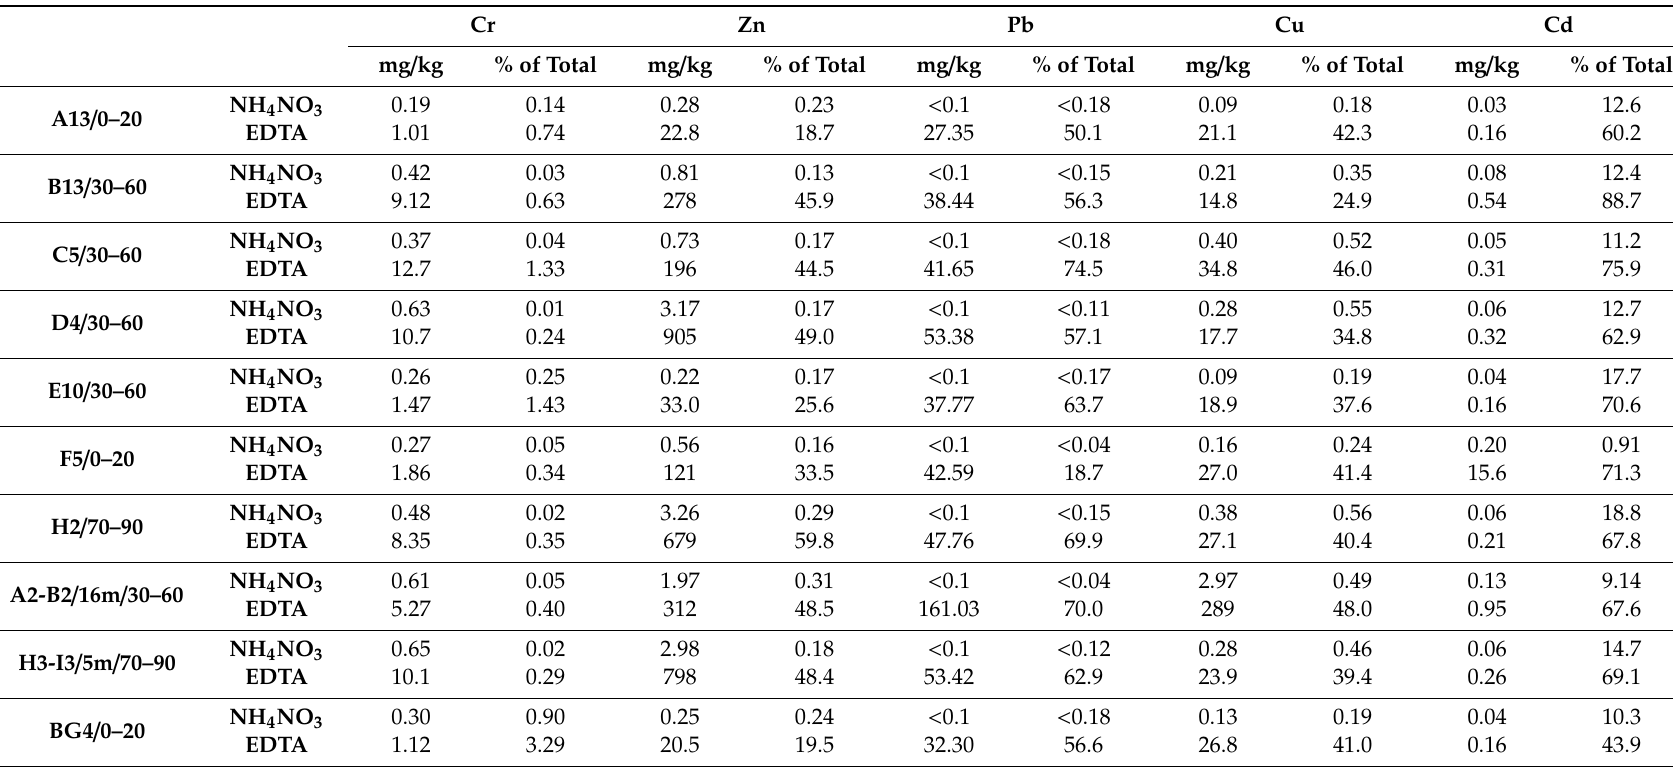
Table 4. Absolute amount (mg / kg) and % of the total content (aqua regia digestion) of the Cr, Zn, Pb, Cu, and Cd extracted by NH 4 NO 3 and EDTA from the 10 selected soil